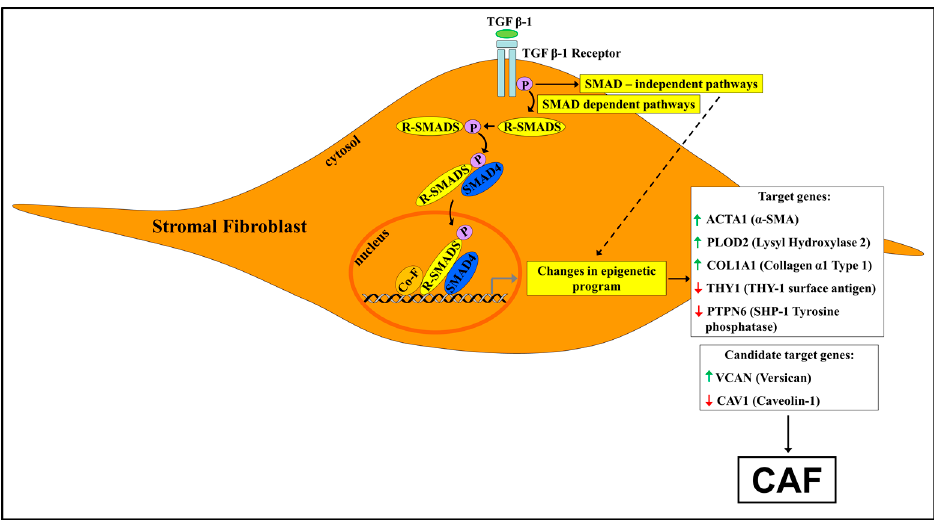
Figure 2. Cancer-derived TGF- β 1 reshapes the epigenetic signature of normal stromal fibroblasts surrounding a growing tumor via SMAD-dependent and SMAD-independent signaling pathways. For clarity’s sake, only the SMAD-dependent pathway is shown. TGF- β 1 signaling induces changes in nuclear enzymes and regulatory proteins such as DNMTs, histone-modifying enzymes and BET proteins governing the multi-tiered epigenetic program of fibroblast cells. The outcome is chromatin reprogramming and the generation in the tumor microenvironment (TME) of pro-tumorigenic CAFs